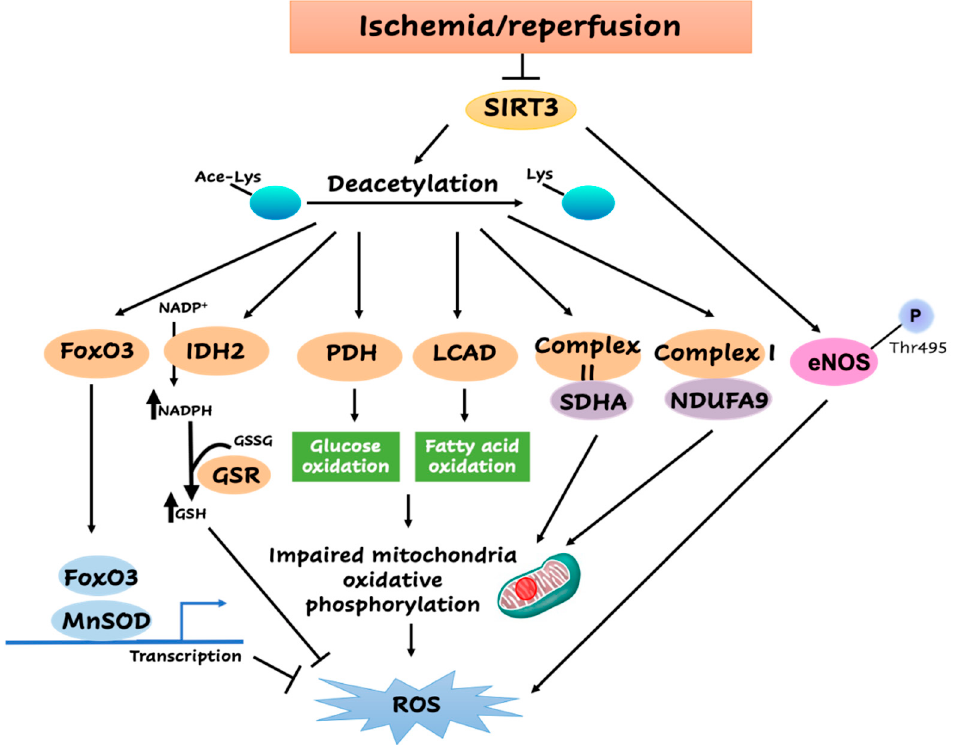
Figure 2. Sirtuin3 (SIRT3)-mediated metabolic downstream events during myocardial ischemia and reperfusion (I/R).